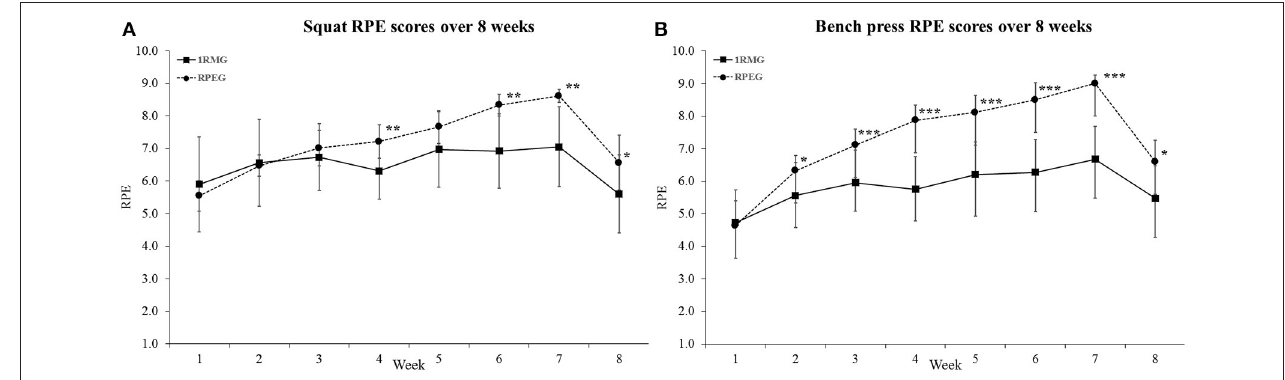
FIGURE 1 | Weekly average RPE values for (A) for squat and (B) bench press. * p < 0.05, ** p < 0.01, and *** p < 0.001. RPE, rating of perceived exertion.